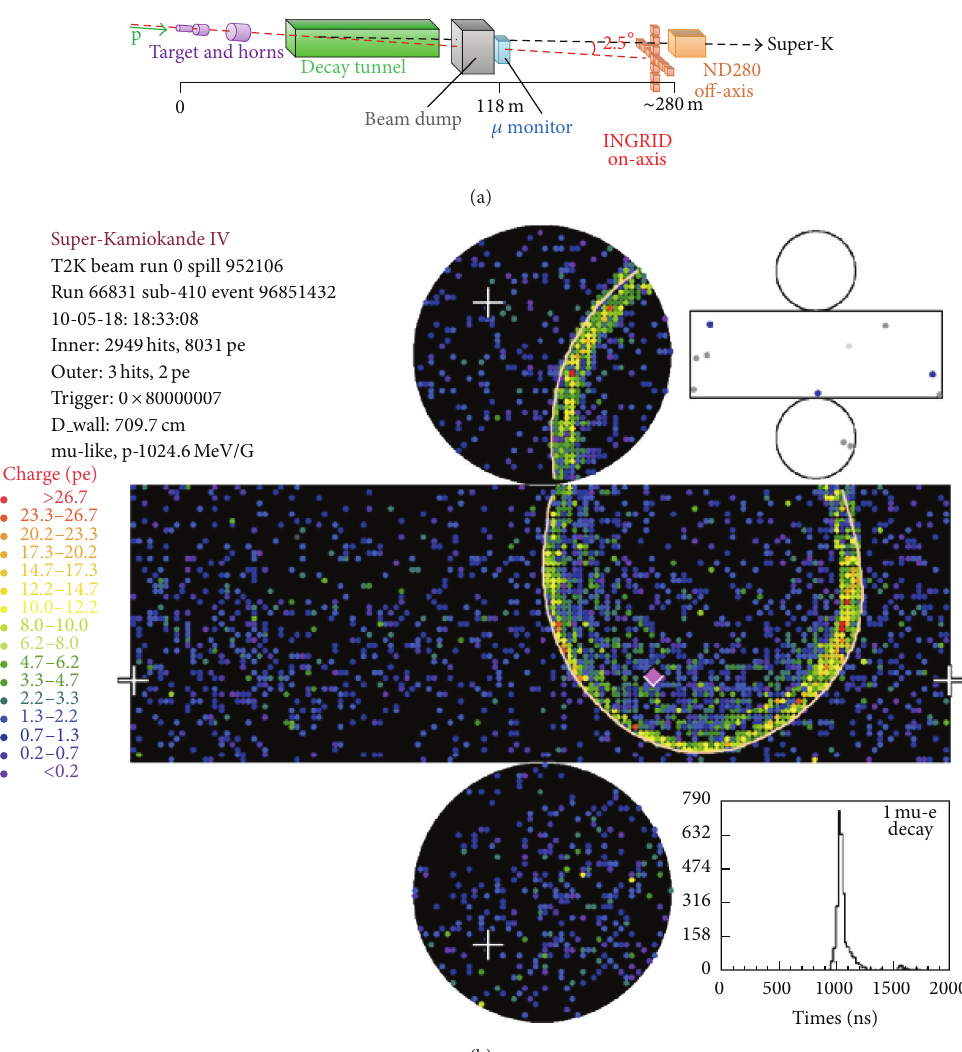
Figure 16: Sketch (a) of the T2K beam line, showing the primary proton beam line, the target station, the decay volume, the beam dump, the muon monitors, and the near on-axis and off-axis neutrino detectors. On (b) a single ring ] 𝜇 event in the SK detector.